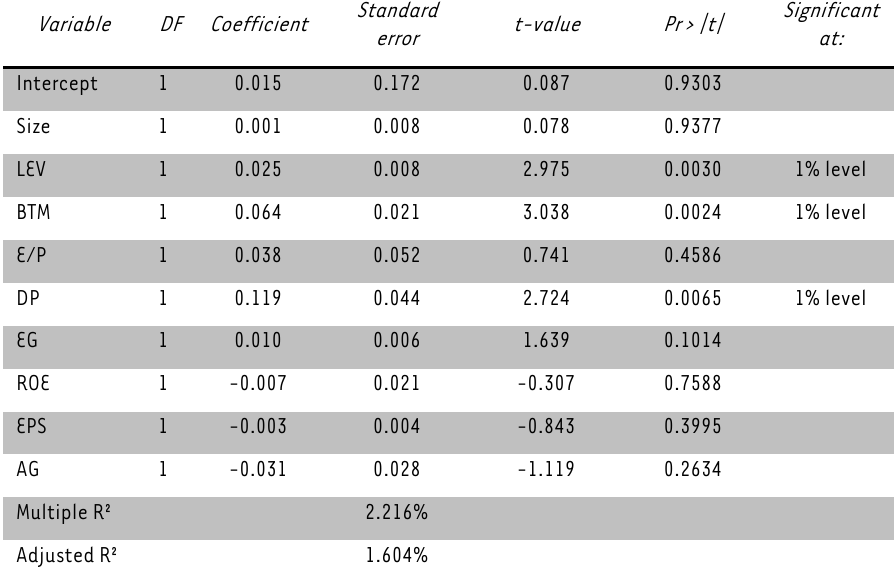
TABLE 3: Multiple regression model with all variables